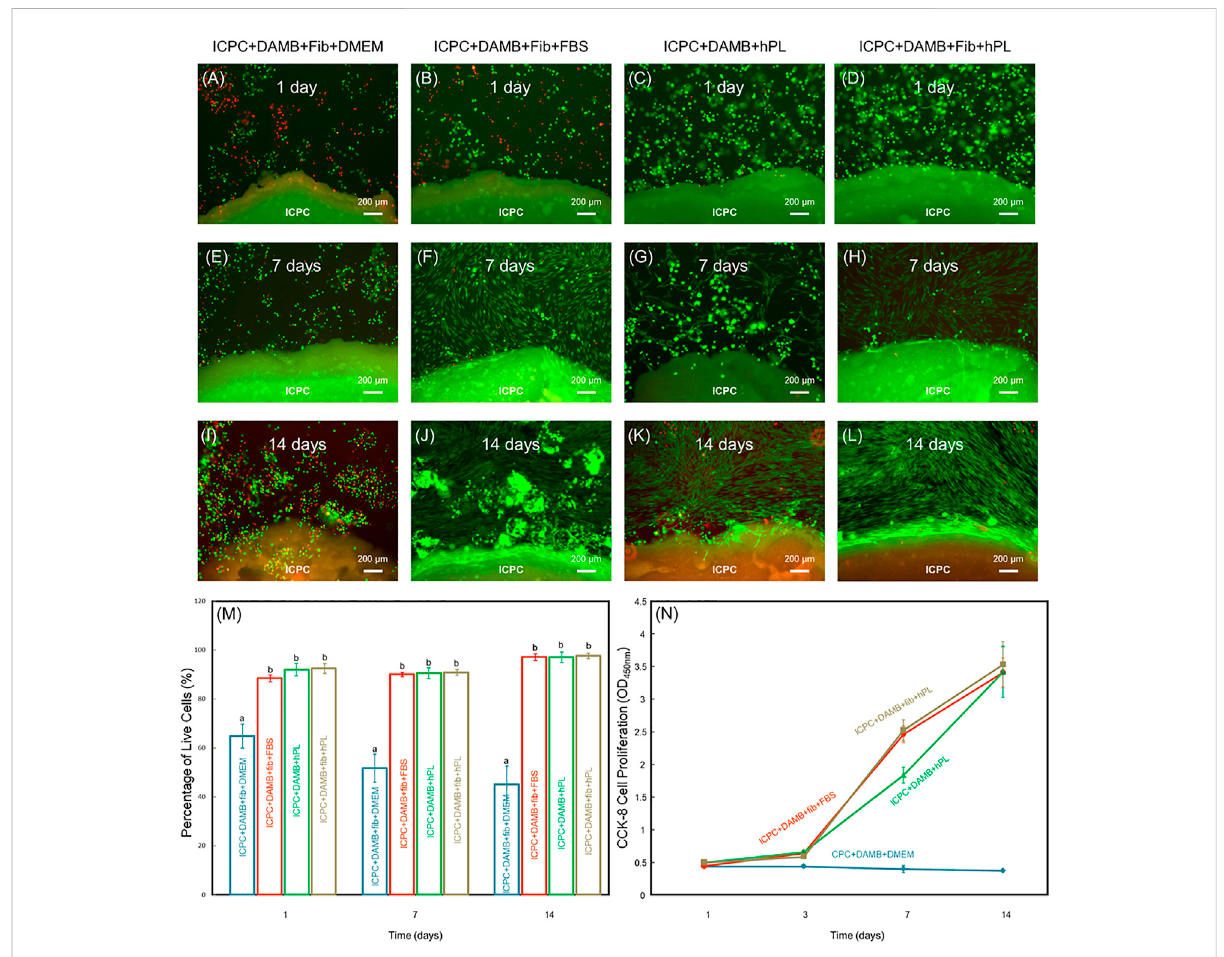
FIGURE 2 Live/dead results of human periodontal ligament stem cells (hPDLSCs) in ICPC + DAMB + fi brin + DMEM, ICPC + DAMB + fi brin + FBS, ICPC + DAMB+hPL,andICPC+DAMB+ fi brin+hPLconstructs (A – L) .Percentageoflivecellsat1,7,and14 days (M) .Eachvalueis(mean±sd; n =5).CCK- 8 cell viability (absorbance at 450 nm) increased with culture time (N) . Each value is (mean ± sd; n = 6). Bars with dissimilar lettersin the plot indicate values that are signi fi cantly different from each other ( p <